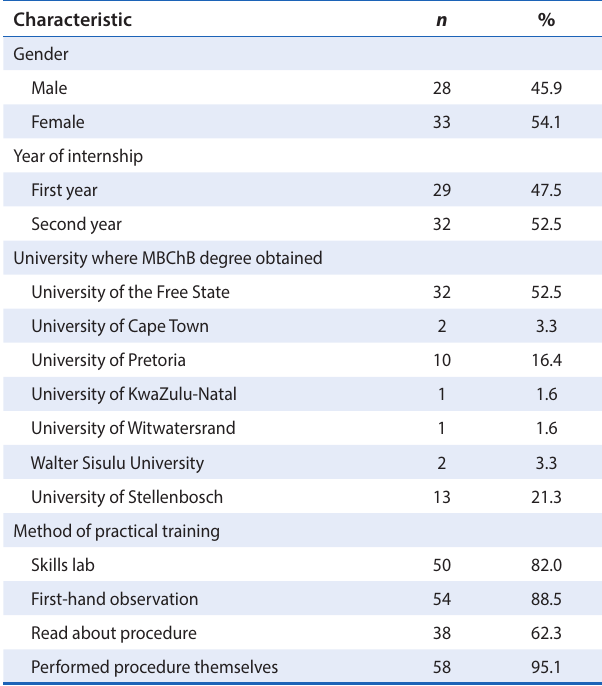
Table 1: Socio-demographic characteristics of participating interns ( n = 61)